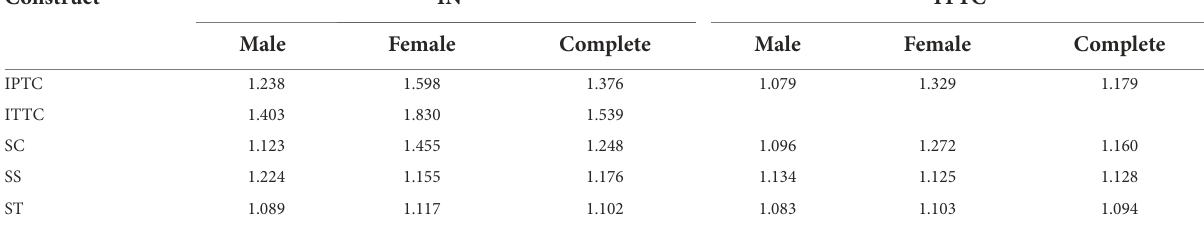
TABLE 5 Collinearity test